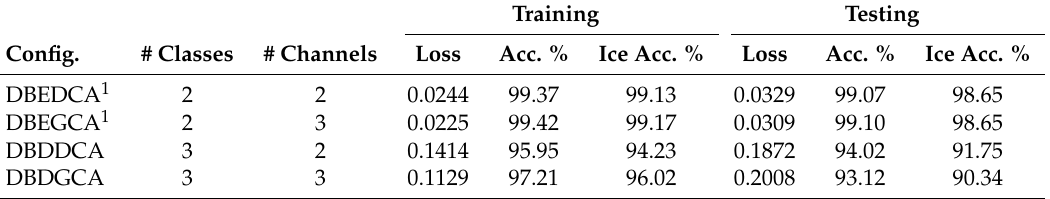
Table 4. DenseNet based classifier